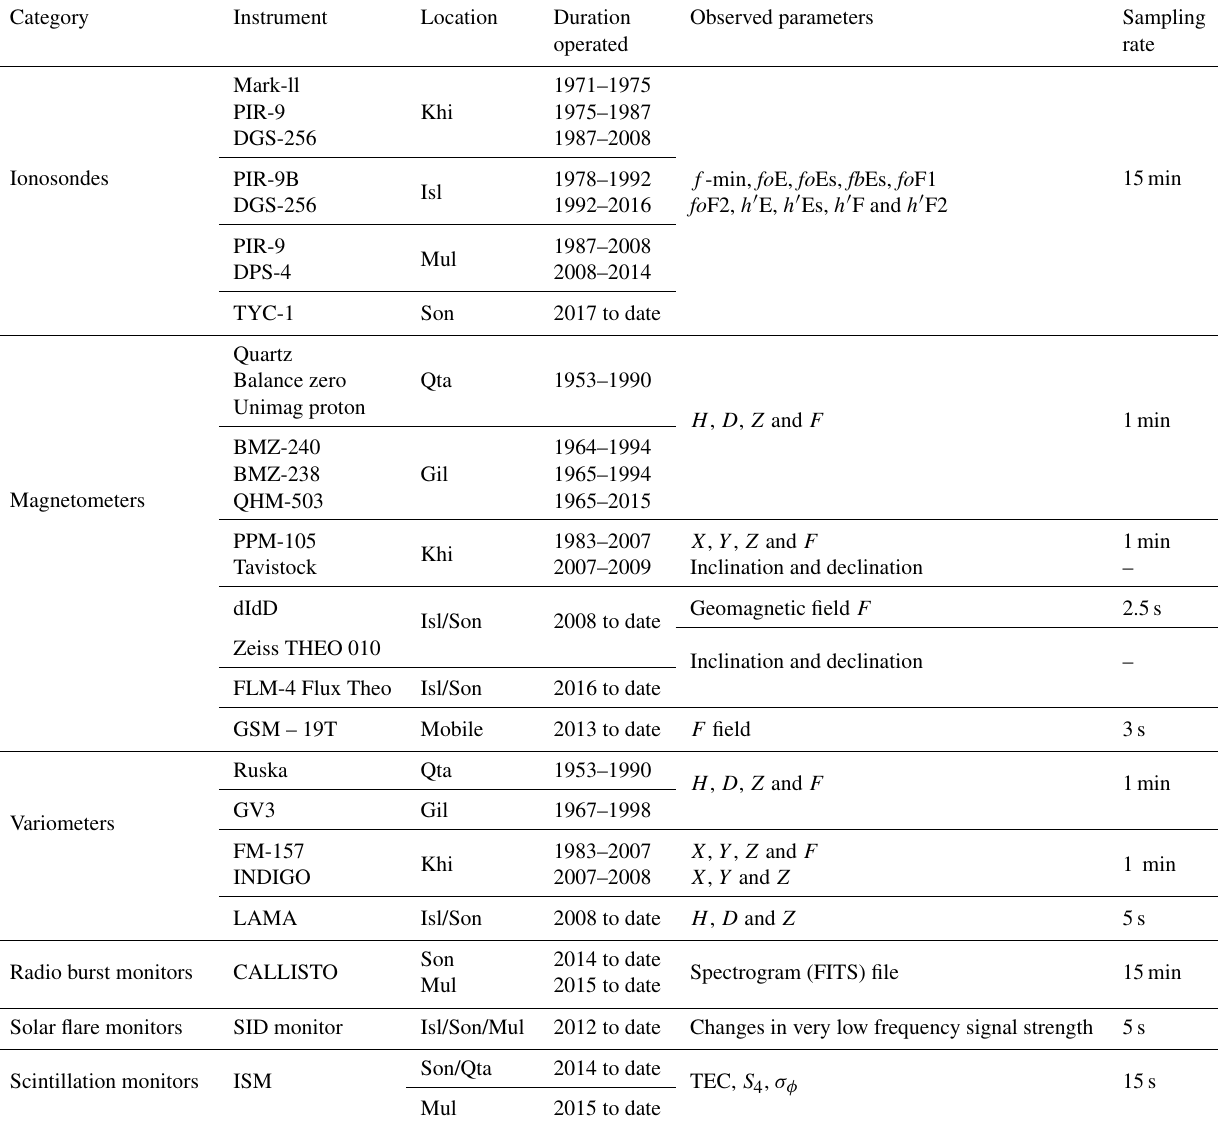
Table 2. Space weather instruments operated in Pakistan to date. Please see Table 1 for the location abbreviations.